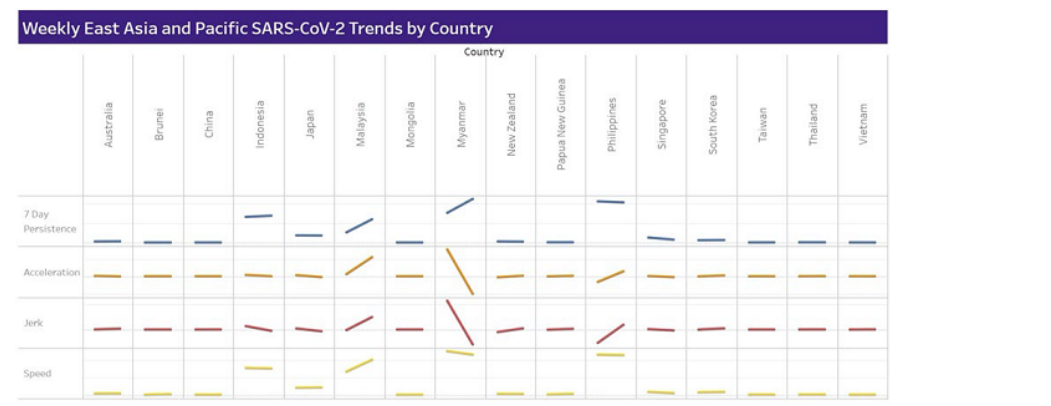
For the week of October 5-11, Indonesia led the East Asian and Pacific region with the highest number of new cases at 4294, followed by the Philippines at 2156 and Myanmar at 2158. The number of deaths follow the same pattern for Indonesia, the Philippines, and Myanmar at 88, 86, and 32 deaths, respectively. For the week of October 12-18 (Table 3), Indonesia, the Philippines, and Myanmar continued to lead the region with 4301, 2588, and 1287 new COVID-19 infections and 84, 72, and 39 deaths, respectively. The cumulative number of deaths for the region reached 28,053 by the second week in